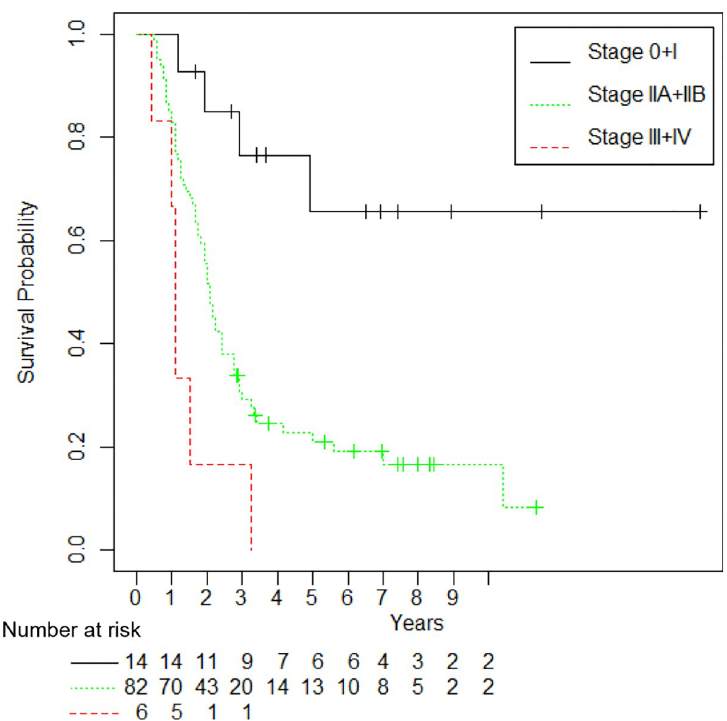
Fig 3. Kaplan-Meier curves for PDAC-related survival according to UICC TNM stage. Kaplan-Meier analysis of PDAC-specific survival by UICC TNM stage is shown.